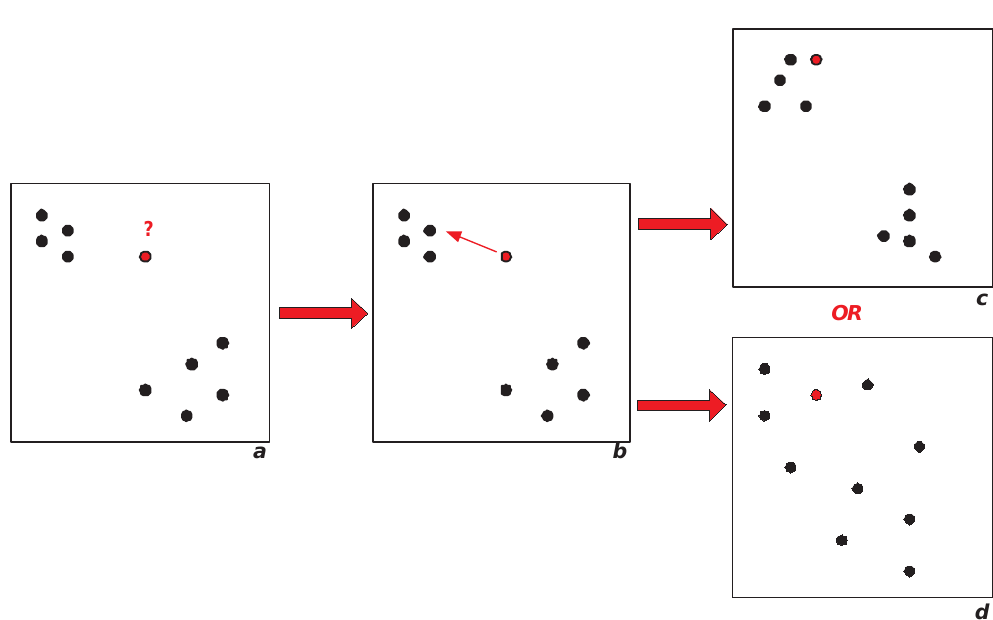
Figure 1: The use of targeted projection pursuit for interactive data exploration. a An initial view of the data with two partial clusters and an outlier. b The user hypothesises that the outlier is part of the upper cluster and drags it into place. c If the data supports such a clustering then the tool finds a view of the data that matches the hypothesis. d The data does not support the hypothesis and moving the point disrupts the partial